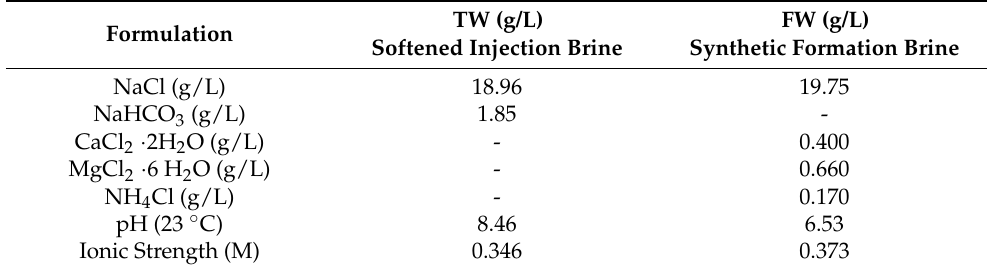
Table 2. Composition of synthetic brines used in this work.